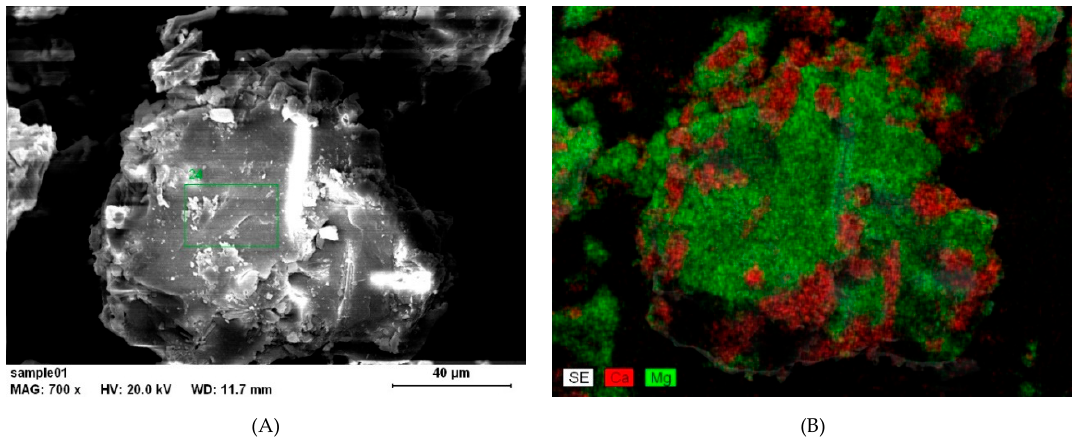
Figure 9. SEM-EDX picture ( A ) and elemental map ( B ) of a representative unwashed Mg(OH) 2 precipitate.